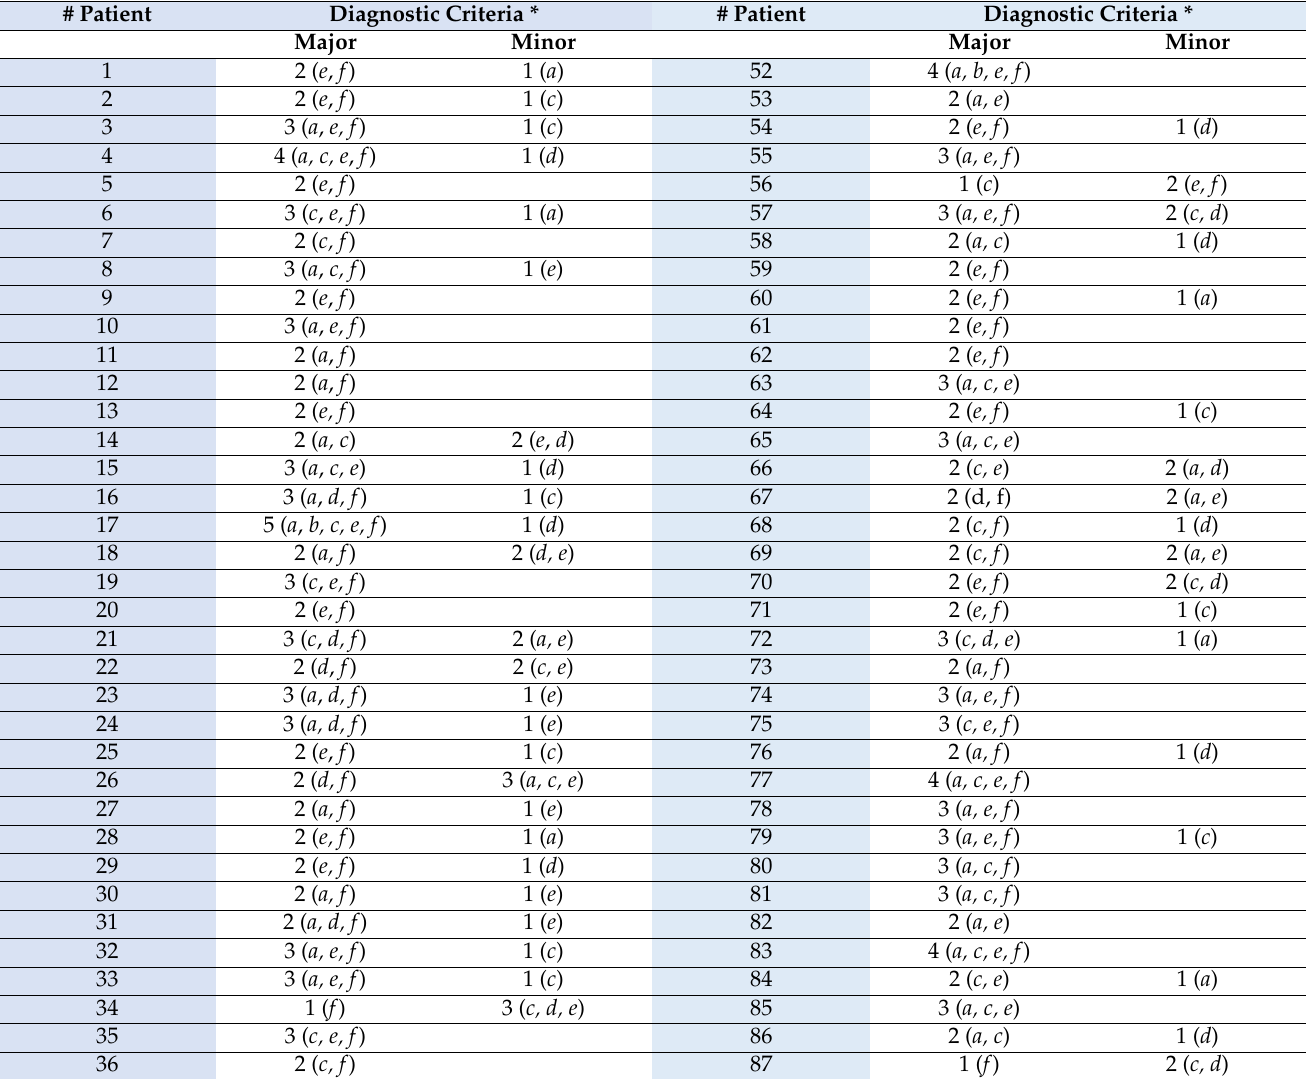
Table 1. The 2010 Task Force Diagnostic criteria fulfilled by the 102 ARVC patients. * Numbers and categories (in parentheses) of fulfilled diagnostic criteria are reported. a, global or regional dys- function and structural alterations; b , tissue characterisation of wall; c , repolarisation abnormalities; d , depolarisation abnormalities; e , arrhythmias; f , family